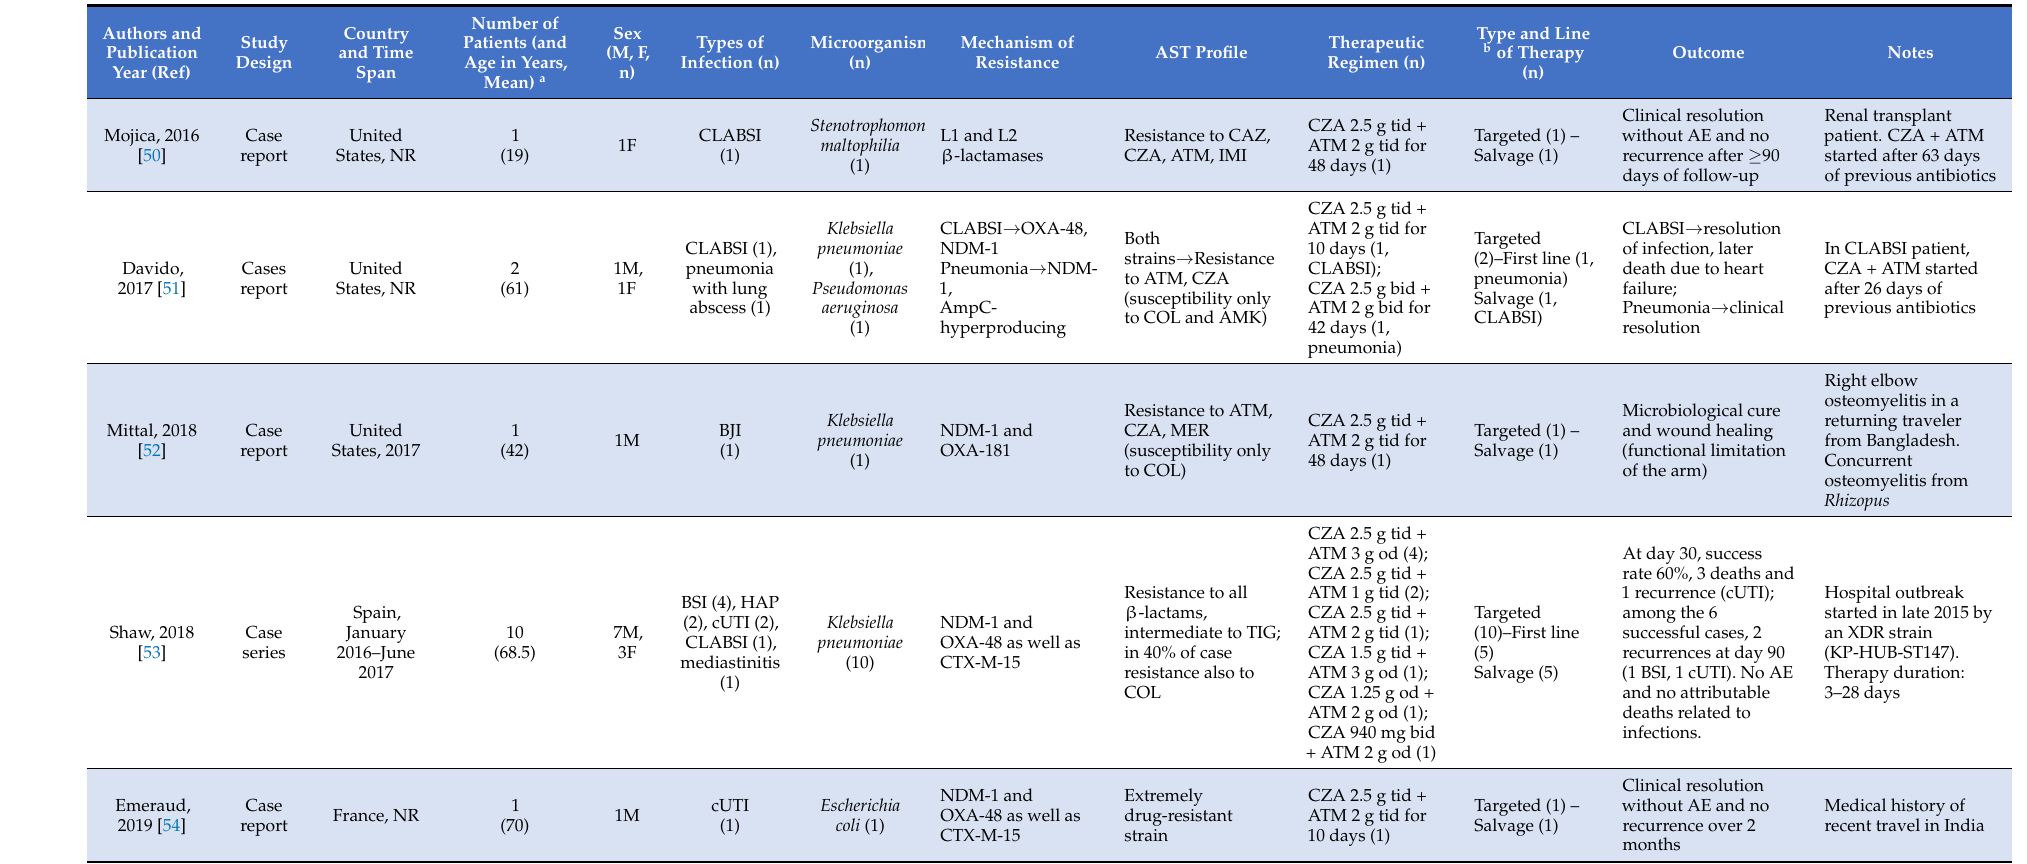
Table 3. Overview of the studies’ features and report of the